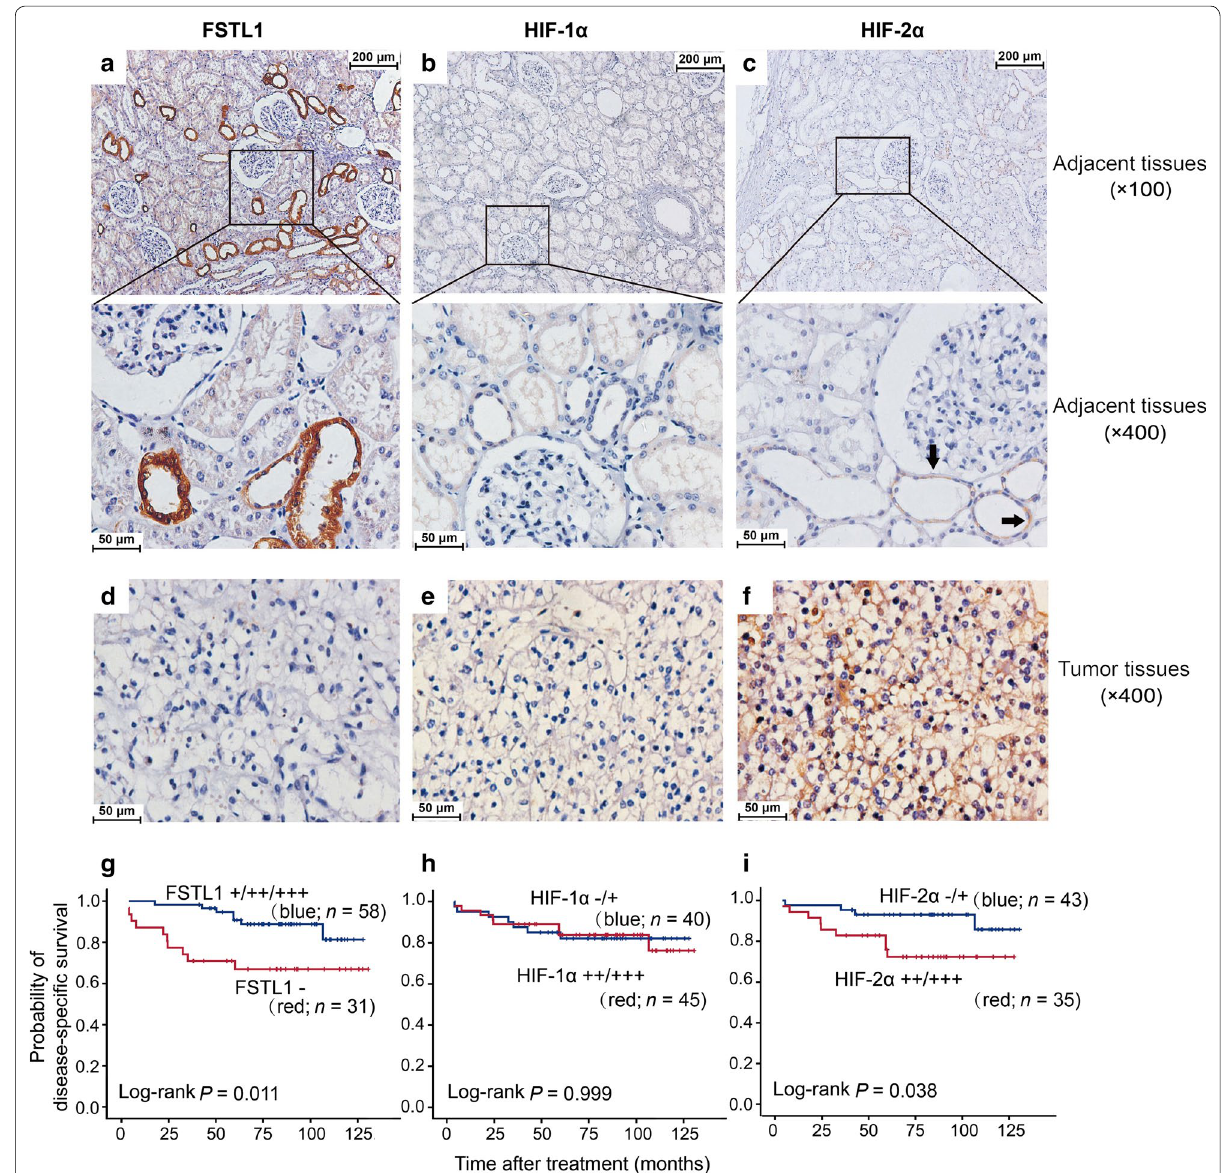
Fig. 6 FSTL1 and HIF-1α/2α levels in ccRCCs and adjacent tissues and their effects on postoperative prognosis. a – c Representative immunostain- ing of FSTL1, HIF-1α, and HIF-2α in adjacent renal tissues, respectively. The HIF-2α positive parts are indicated by black arrows. d – f Representative